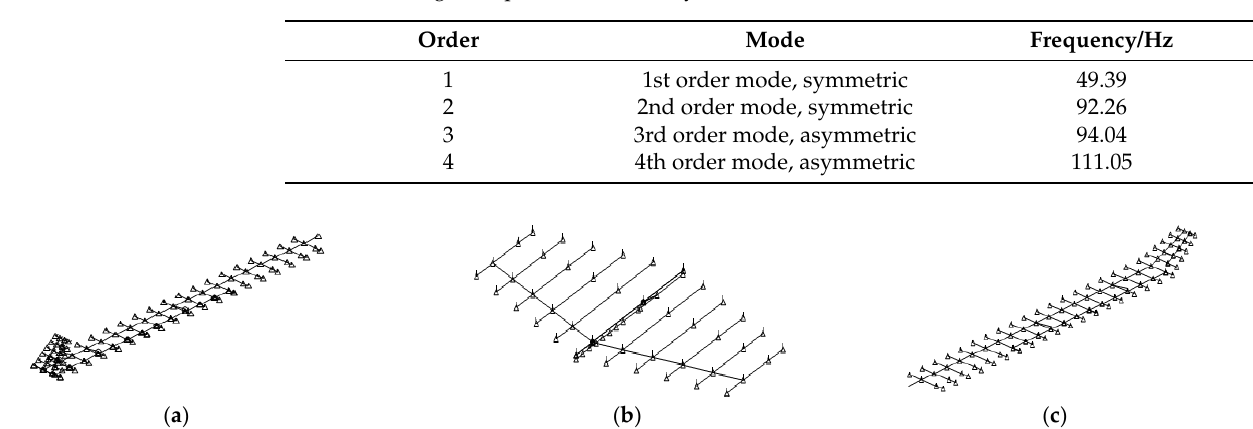
Table 4. Fuselage component mode analysis results.